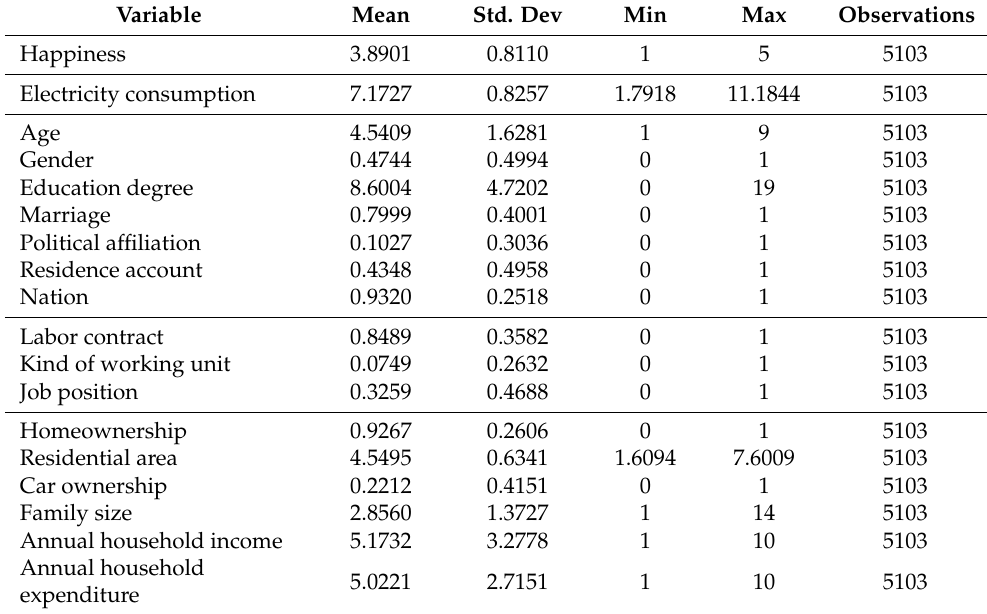
Table 2. Variable descriptive